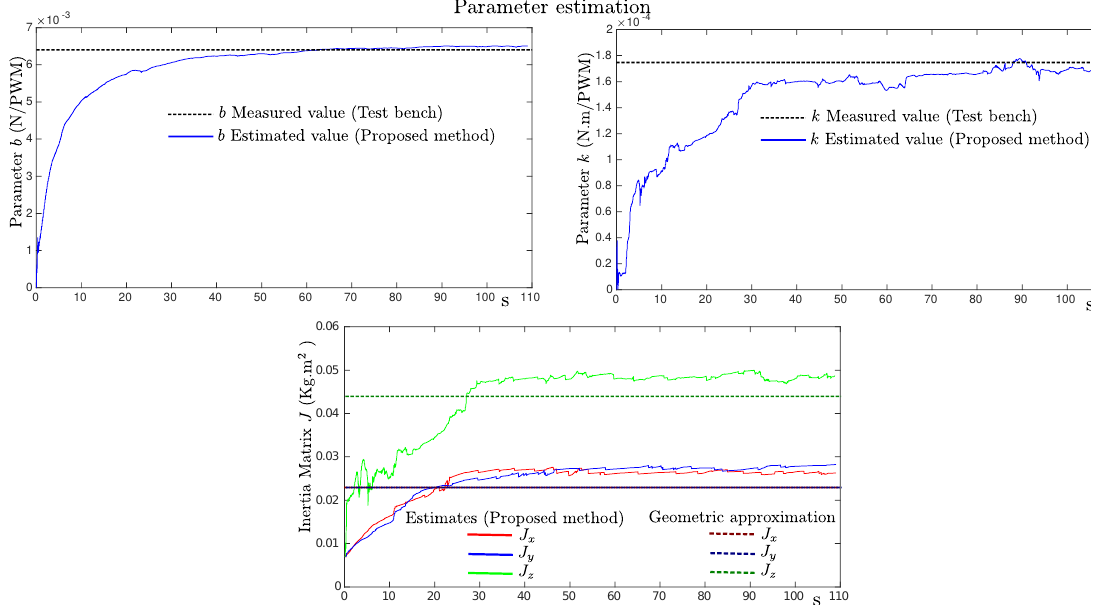
Figure 9. Estimates of the model parameters ( J x , J y , J z , b , k ) obtained from the flight log data of the quadrotor.